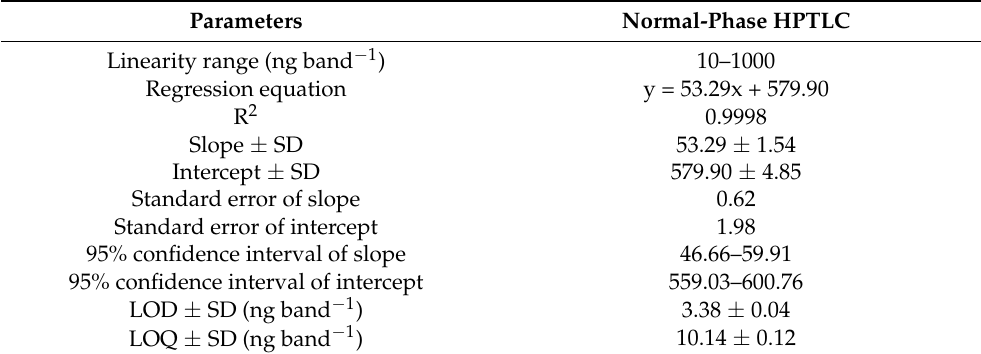
Table 1. Results of least square regression analysis for piperine (PPN) for a sustainable